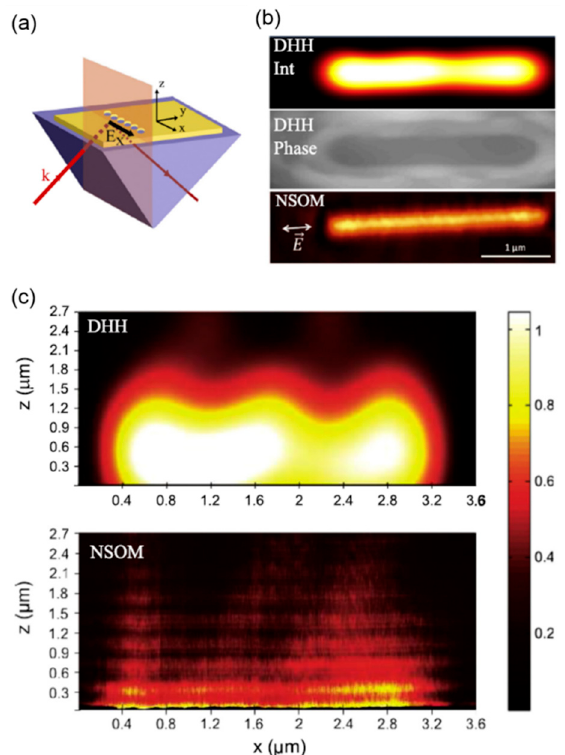
Figure 10. Resonant illumination of nano hole antenna. ( a ) Nano hole antenna experimental configuration; ( b ) 2D scan of the nano hole surface using far-field DHH imaging and phase as well as c-SNOM; ( c ) Scattered light intensity in a plane perpendicular to the sample surface. Reproduced with permission from [49], Copyright Optics Communications, 2016.